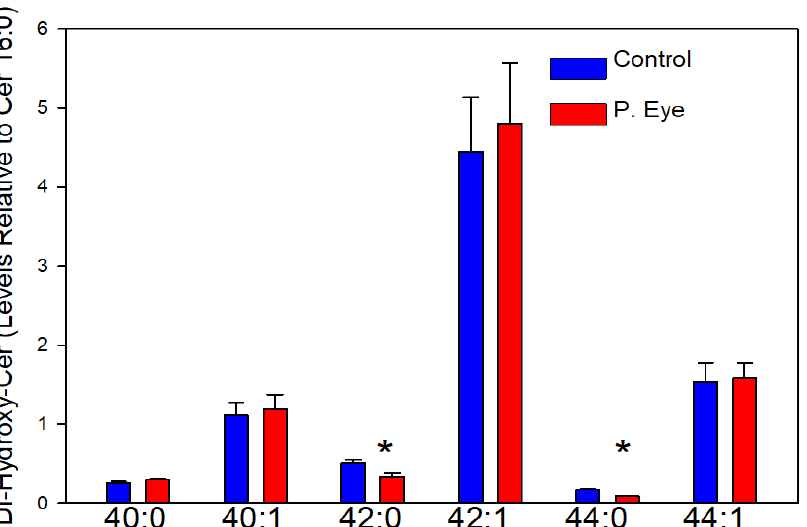
Figure 5. Tear film levels of di-hydroxy-phytoceramides (CerX-O5) in controls and cows with pink eye (P. Eye). The peak intensities of individual di-hydroxy-phytoceramides are expressed as a ratio of the peak intensity of ceramide d18:1/16:0. *, significant t -test statistics: 42:0-O5 (0.021) and 44:0-O5 (0.0090).